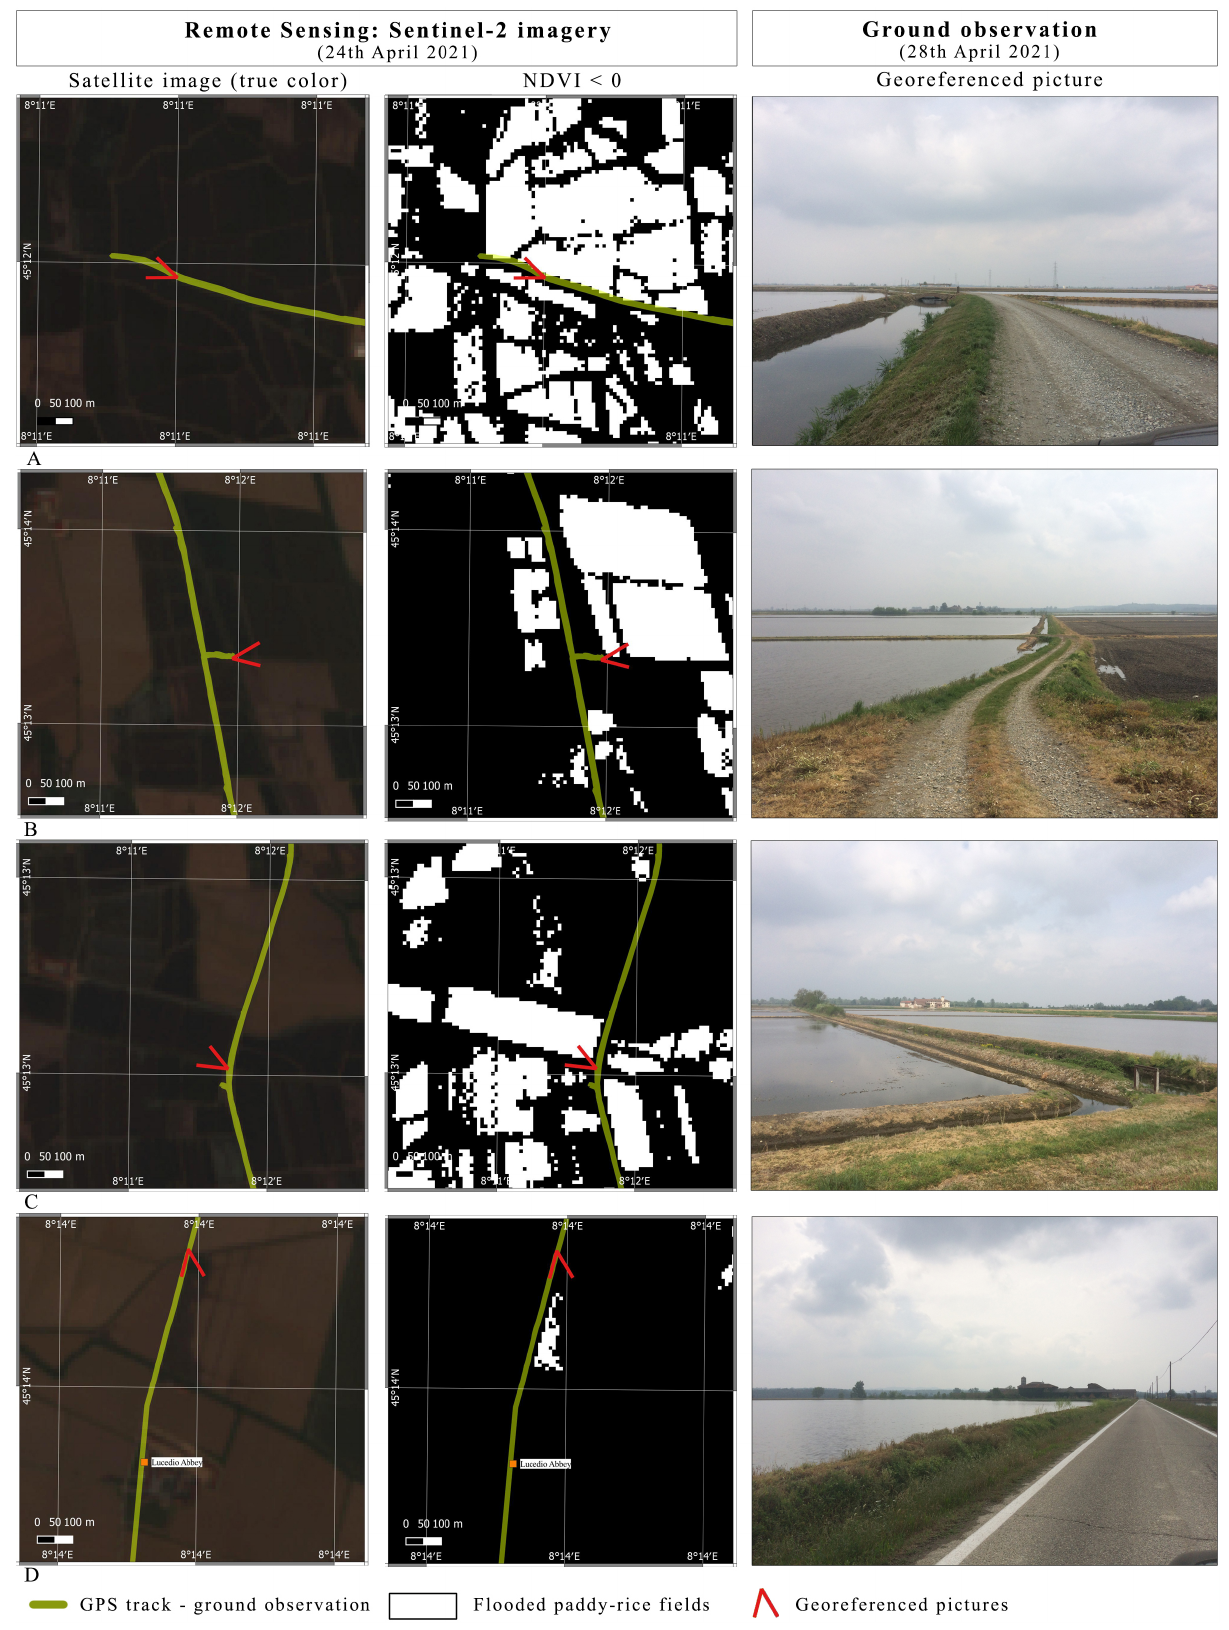
Figure 6 . Comparison between the pixel-based recognition method, based on Sentinel-2 imagery (24th April 2021) and ground observation (28 th April 2021). The abacus shows four different locations in the historical landscape of paddy-rice fields, selected in the survey. Although there are four days between the two observations, there is a good match between the